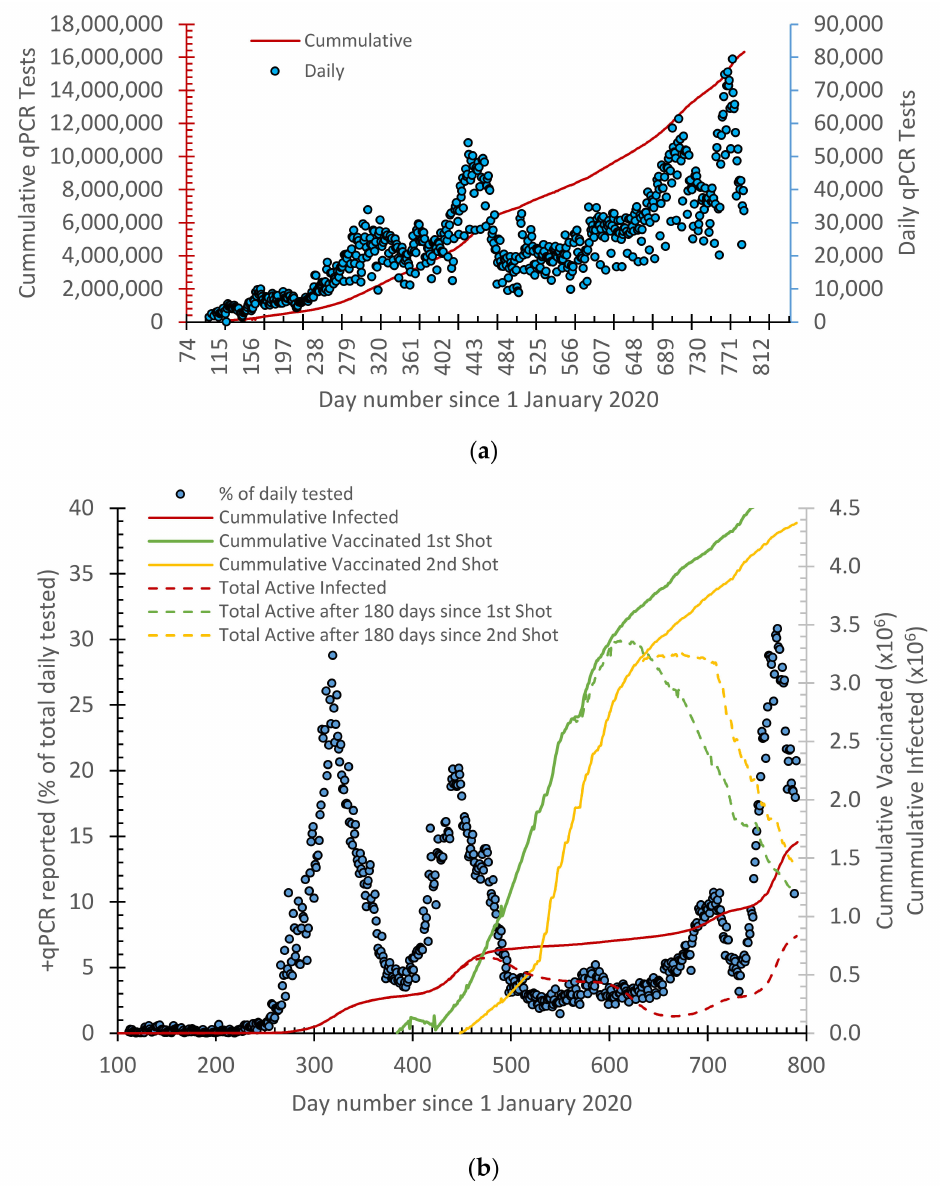
Figure 2. ( a ) qPCR tests performed in Jordan since 14 March 2020 and ( b ) percentage +qPCR cases overlayed with cumulative curves for the vaccination (first and second shots), as well as active cases representing herd